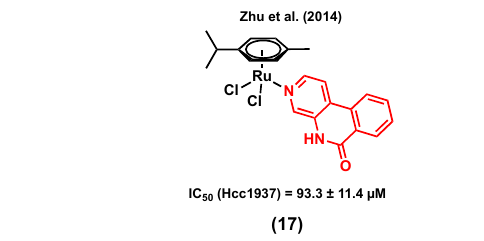
Figure 5. A ruthenium complex bearing Poly (ADP-ribose) polymerase (PARP) inhibitor.